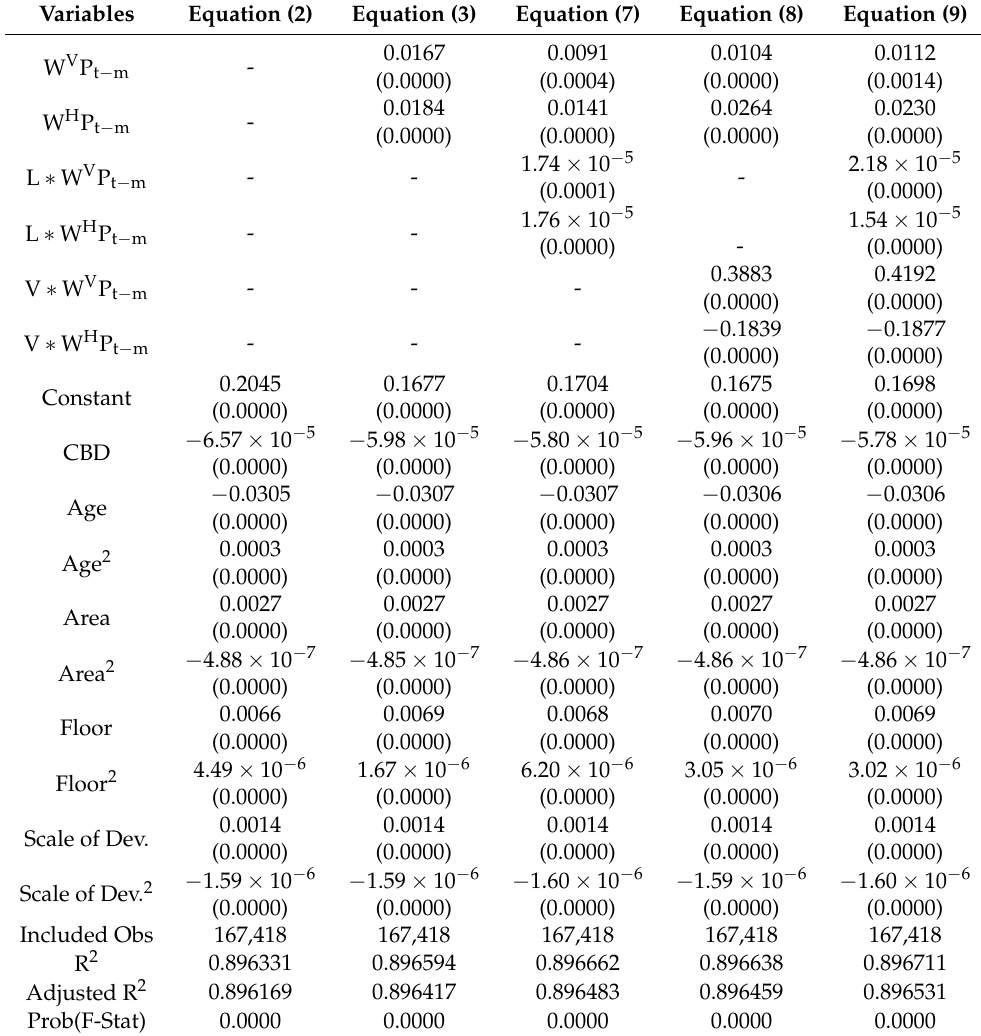
Table 3. Regression